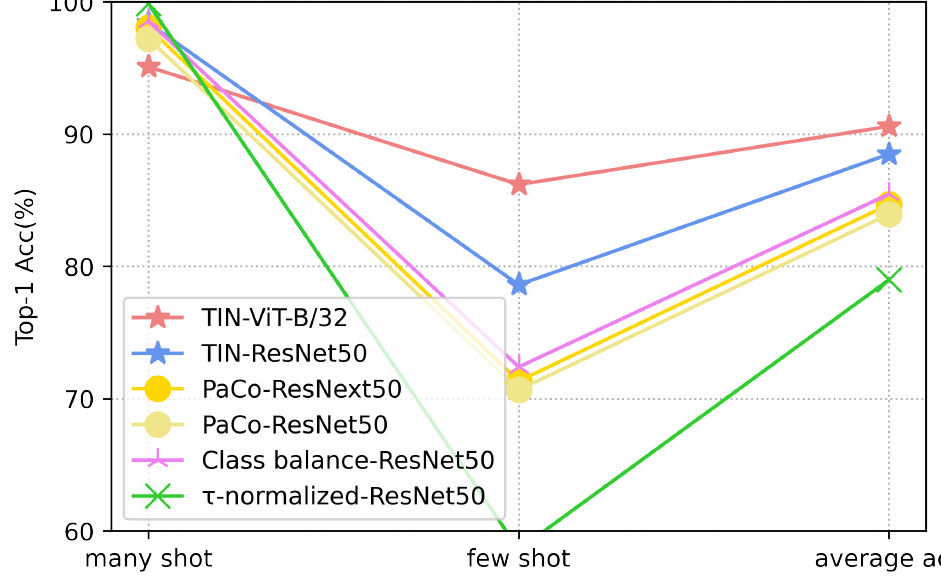
Figure 5. Comparison with the state-of-the-art approaches on Clamp dataset. TIN with ResNet-50 visual backbone outperforms models with a more complex structure and longer training epochs by a large